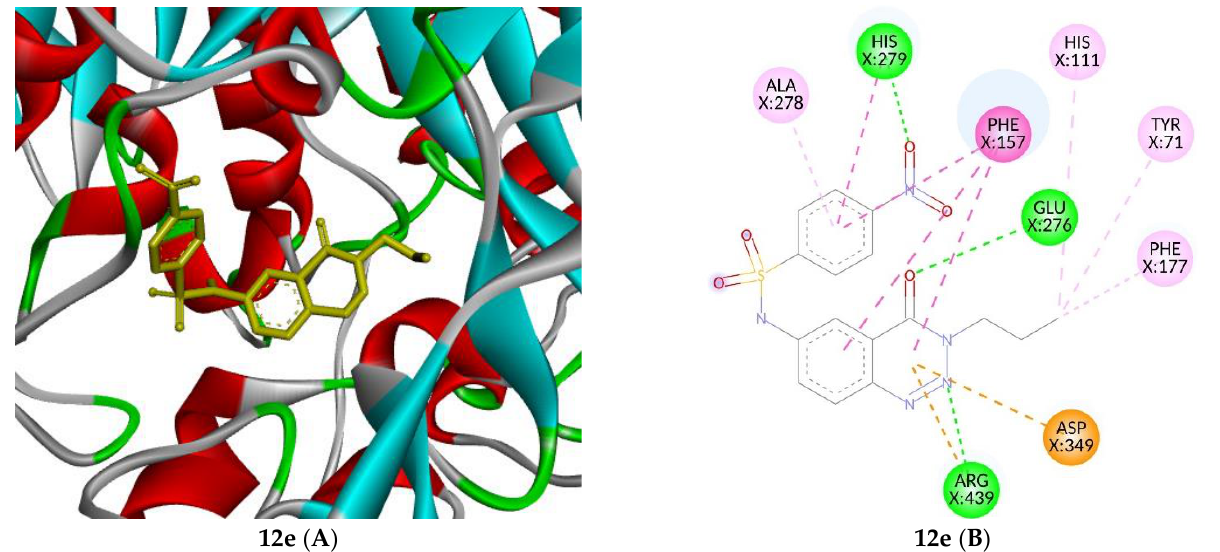
Figure 3. 2D ( B ) and 3D ( A ) structures illustrating docking results, ligand 12e within alpha-glucosidase develops the interactions shown by colored lines; hydrogen bonding (green), pi-cationic/pi anionic interaction (brown), pi-pi interaction (pink) and pi-alkyl interaction (purple).